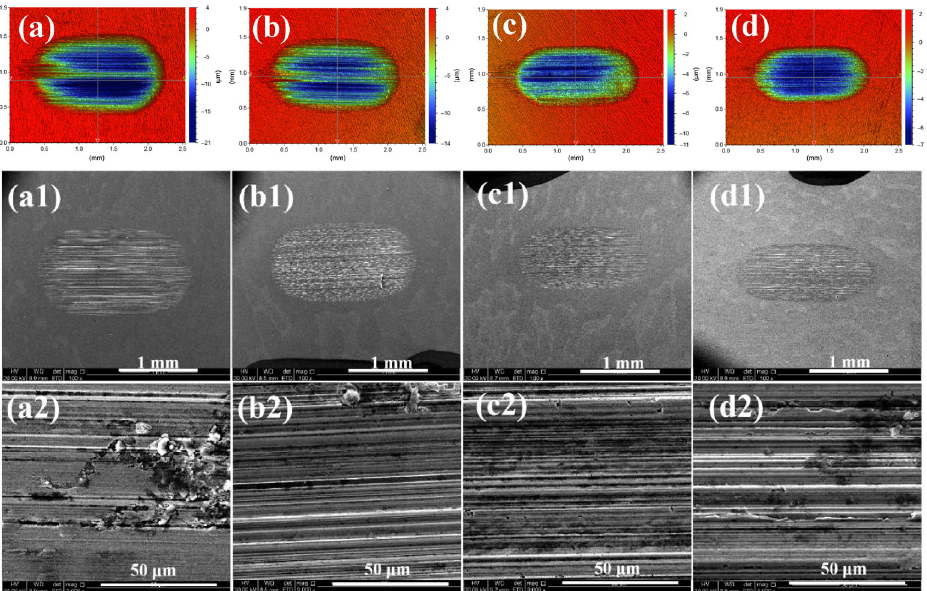
Fig. 7 Three-dimensional profiles of (a) BTA-P 4444 , (b) 1% BTA-P 4444 -Lig, (c) 3% BTA-P 4444 -Lig, and (d) 5% BTA-P 4444 -Lig lubricating materials at high temperatures; (a1–d1) overall appearances of wear spots photographed by the SEM at 100-time magnificaiton; and (a2–d2) surface morphologies of wear spots photographed by the SEM at 3,000-time